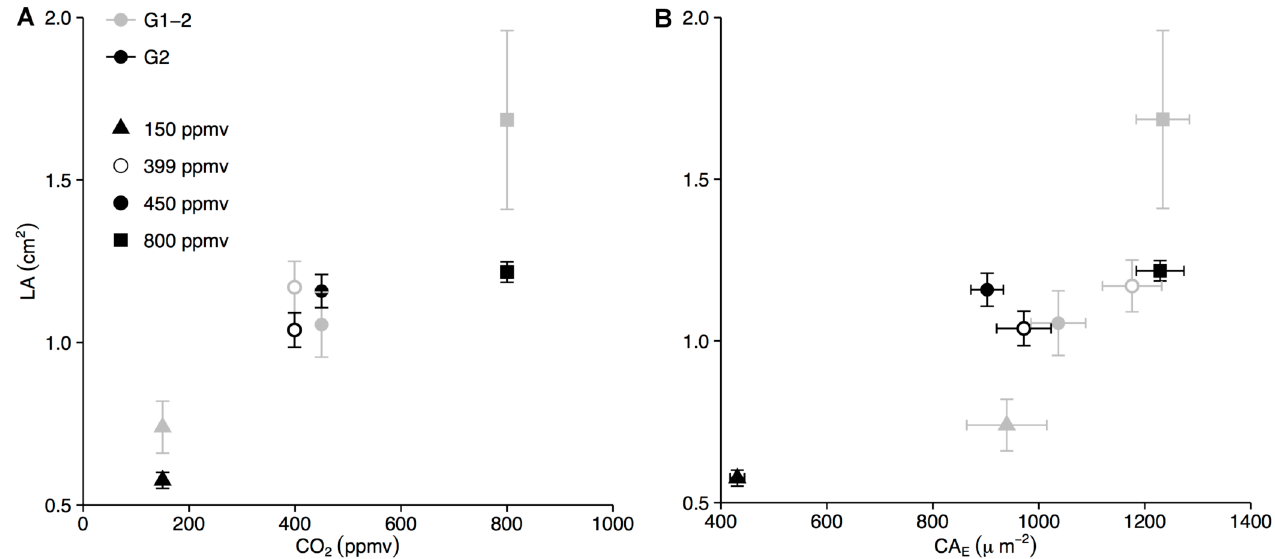
Fig 1. LA of B . nana leaves increases with CO 2 and CA E in G1-2 and G2. (A) LA was higher in successive CO 2 steps in G1-2 and G2. Greenhouse leaves had slightly, but not significantly, larger LA than leaves grown in the 450 ppmv CO 2 chamber. (B) Larger leaves have larger CA E . Error bars represent standard error of the